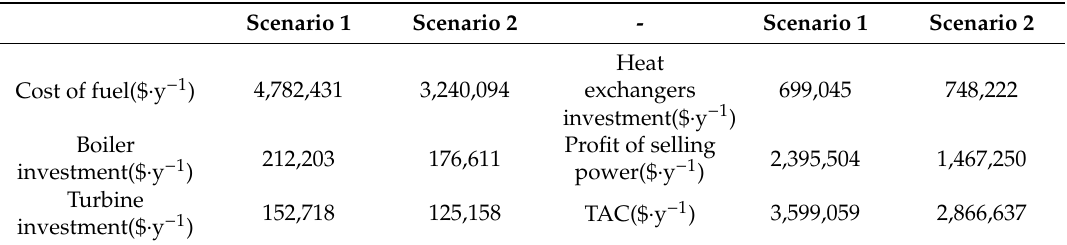
Table 2. Results of Scheme 1.